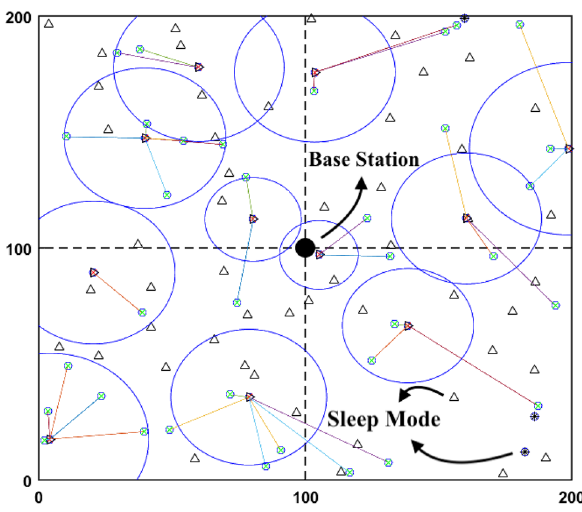
Fig. 1 An instance of peace mode in the first protocol Fig. 2 An instance of semi-alert mode in the first